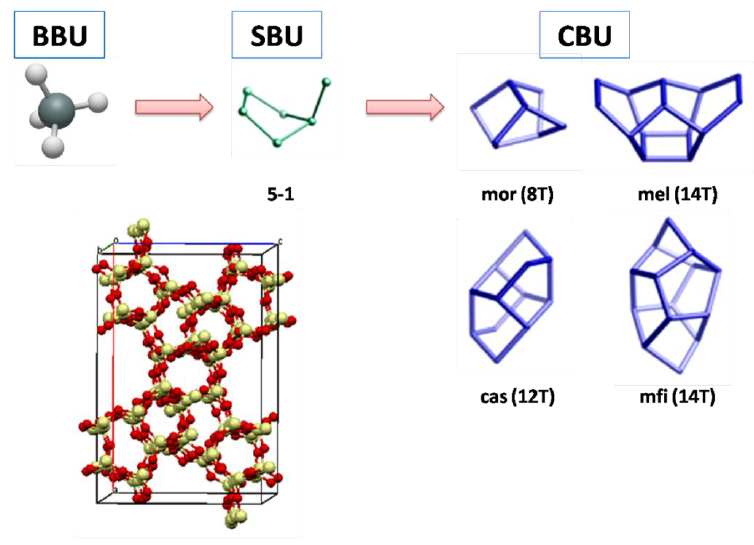
Figure 1. Construction of an MFI zeolite (adapted from the IZA Database website with permission from ref. 12, copyright © 2017 Structure Commission of the International Zeolite Association (IZA-SC) [12]).